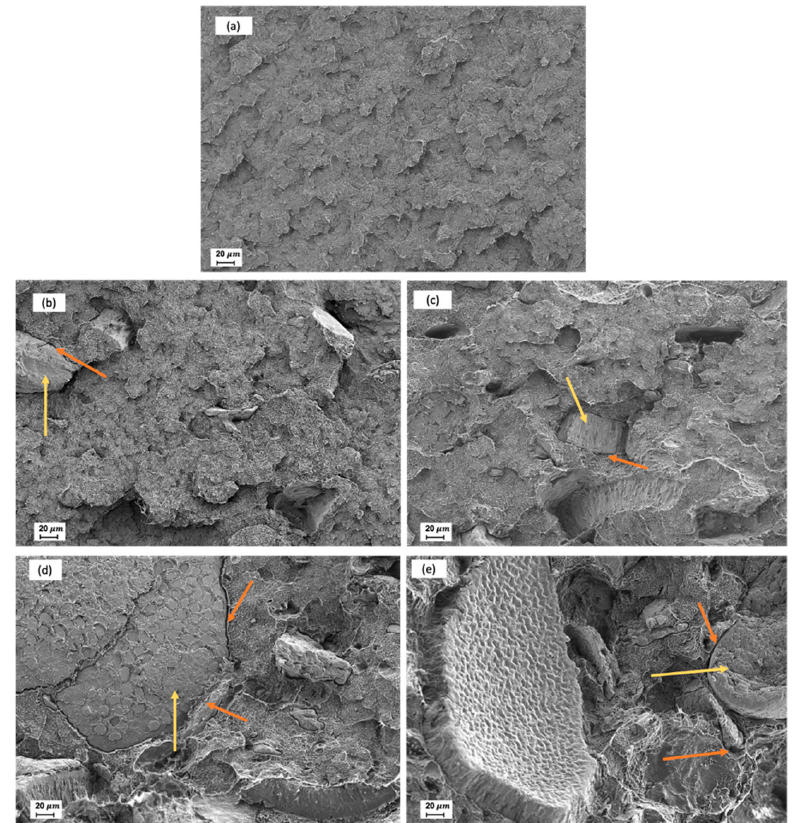
Figure 8. Fracture surface morphology of Charpy test by FESEM at 250 × with different percentage of treated chia seed flour: ( a ) Bio-based high-density polyethylene; ( b ) 10 wt.%; (c) 20 wt.%; ( d ) 30 wt.%; ( e ) 40 wt.%.